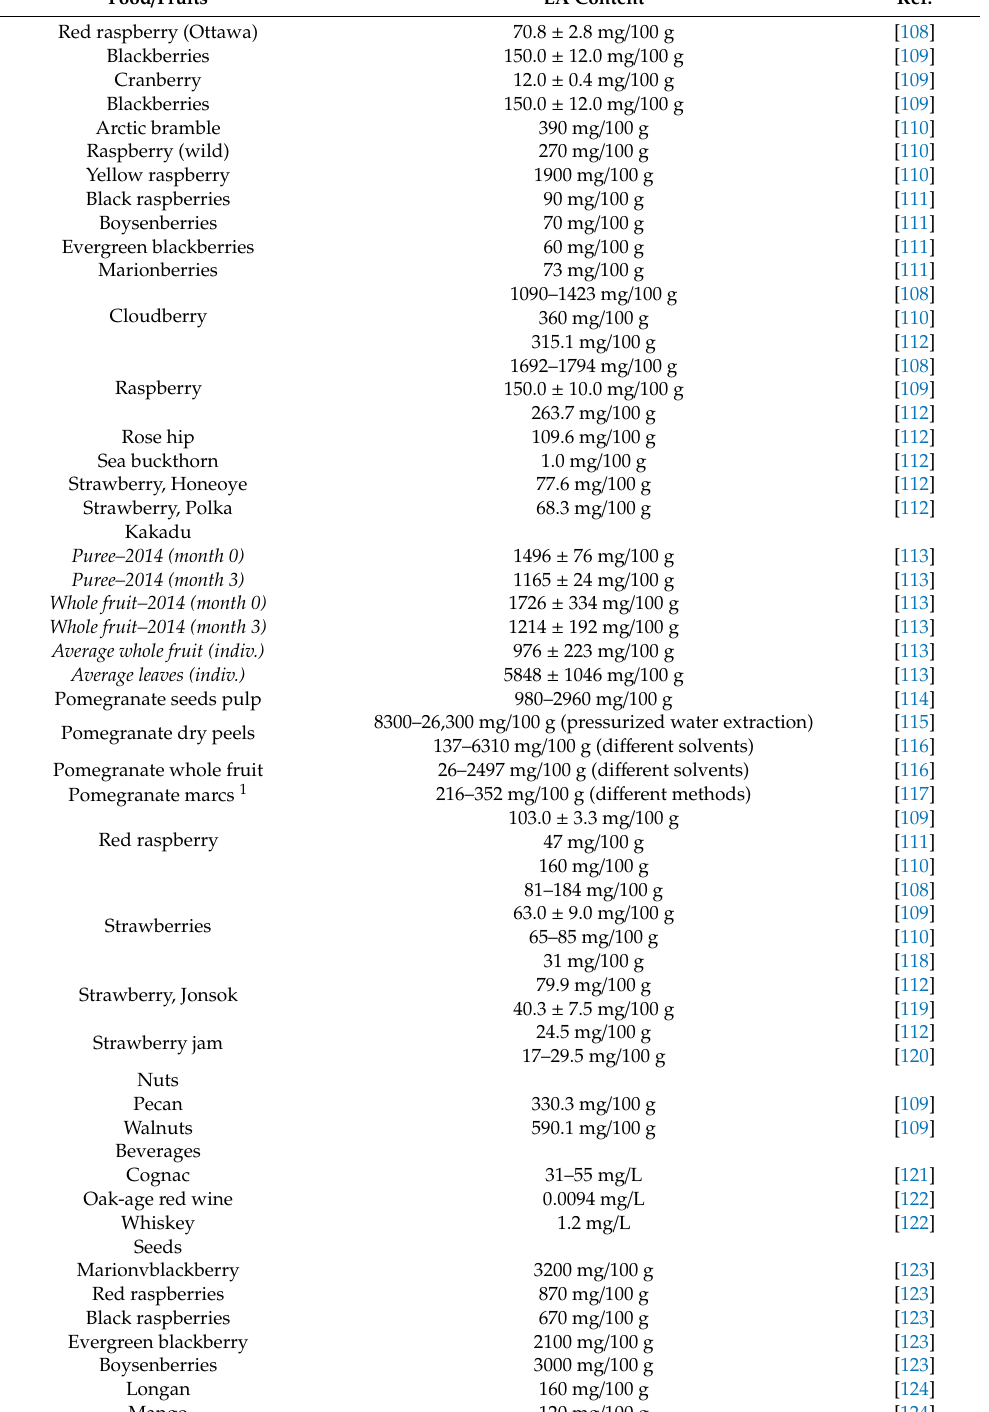
Table 8. Contents of ellagitannins (EA) in fruits, nuts (mg / 100 g of fresh weight), in beverages (mg / L), and in seeds (mg / g seed). The total EA content is estimated after acid hydrolysis so as to include ETs in the estimation